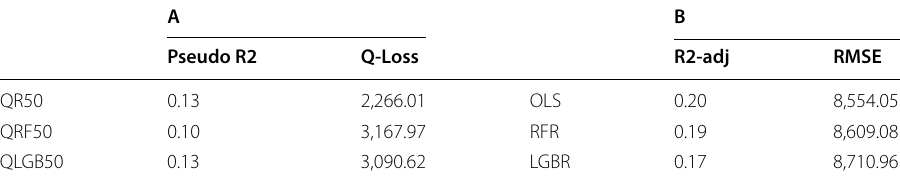
Table 8 Regression models results of pseudo R2, quantile loss, adjusted R2, and root mean squared error for First Income variable